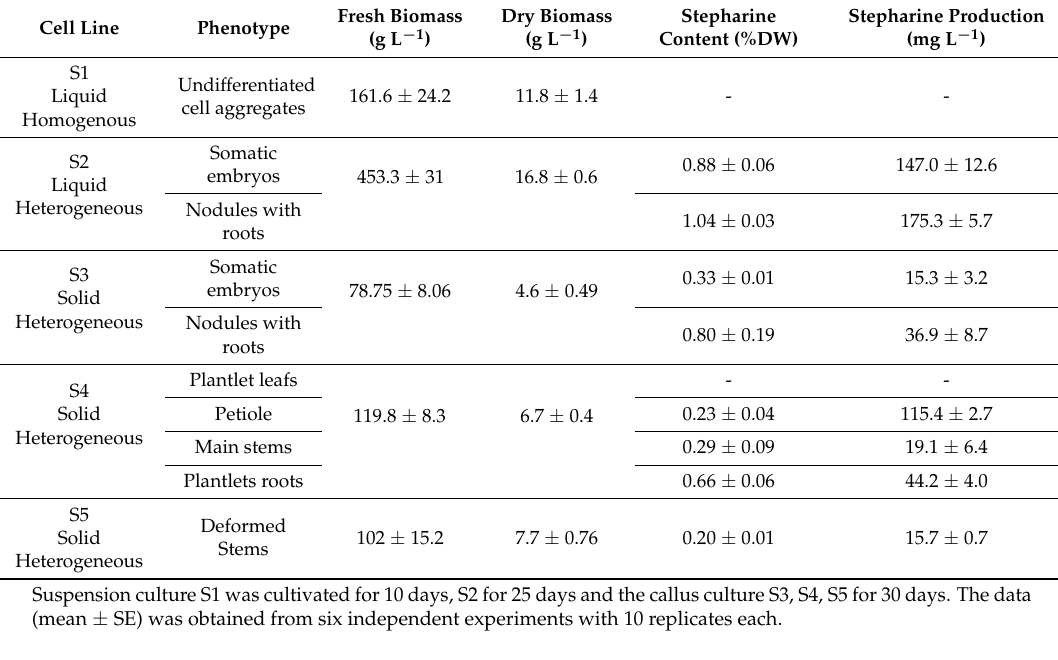
Table 1. The phenotype and the main biotechnological parameters of the S. glabra lines (dark conditions) and rooted plants.